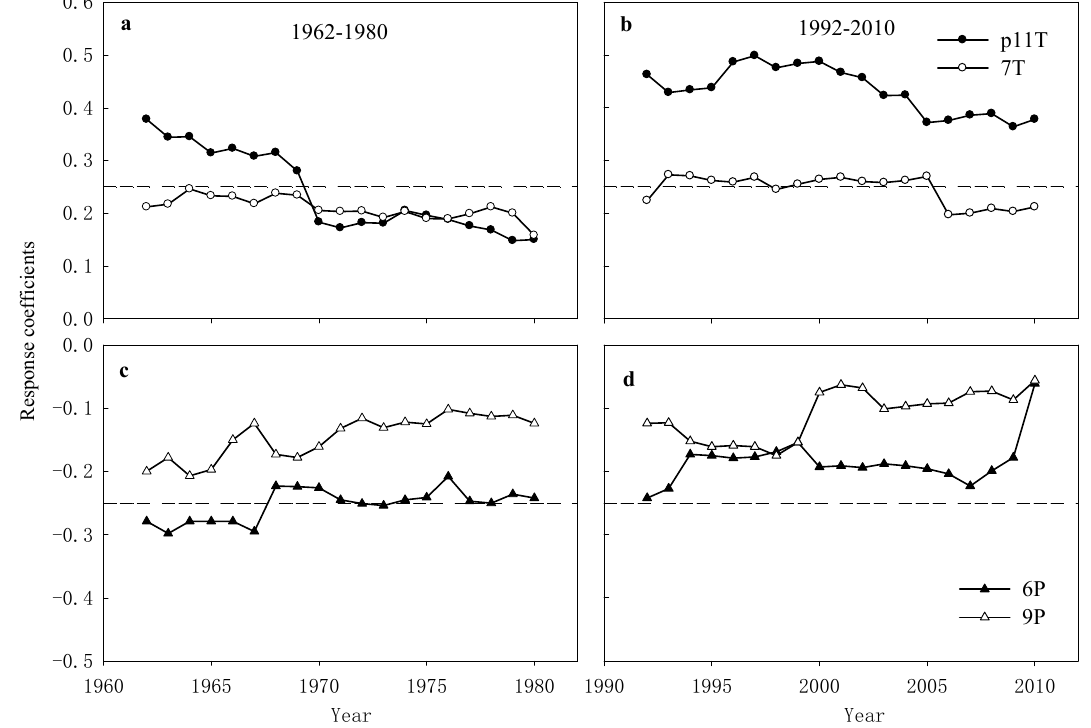
Figure 8. Moving interval analysis between PC#1 of four chronologies and climate variables, A window with 32-year ( a , c ) backward (1962–1980) and ( b , d ) forward (1992–2010) evolutionary intervals. Dashed line indicates the 95% confidence level. A significantly positive relationship occurred when dotted lines were above significant level, while dotted lines below the significant level indicated a significantly negative relationship.